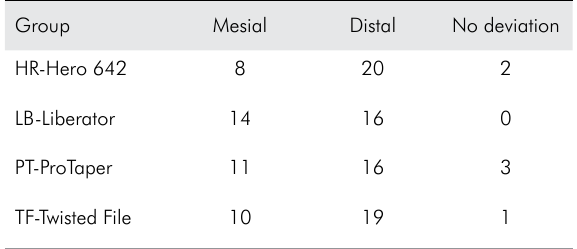
Table 2. Canal transportation direction among groups.